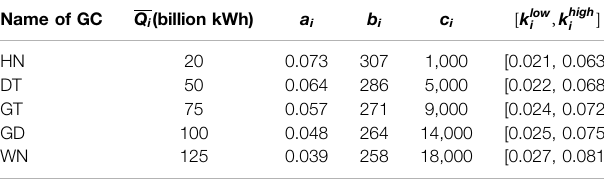
TABLE 1 | Generation costs and bidding